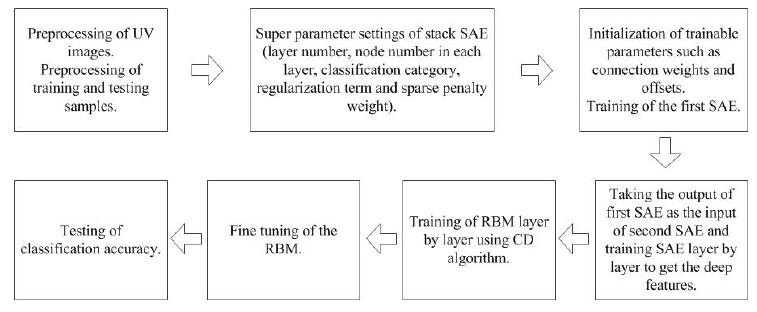
Figure 9. Flowchart of the algorithm.